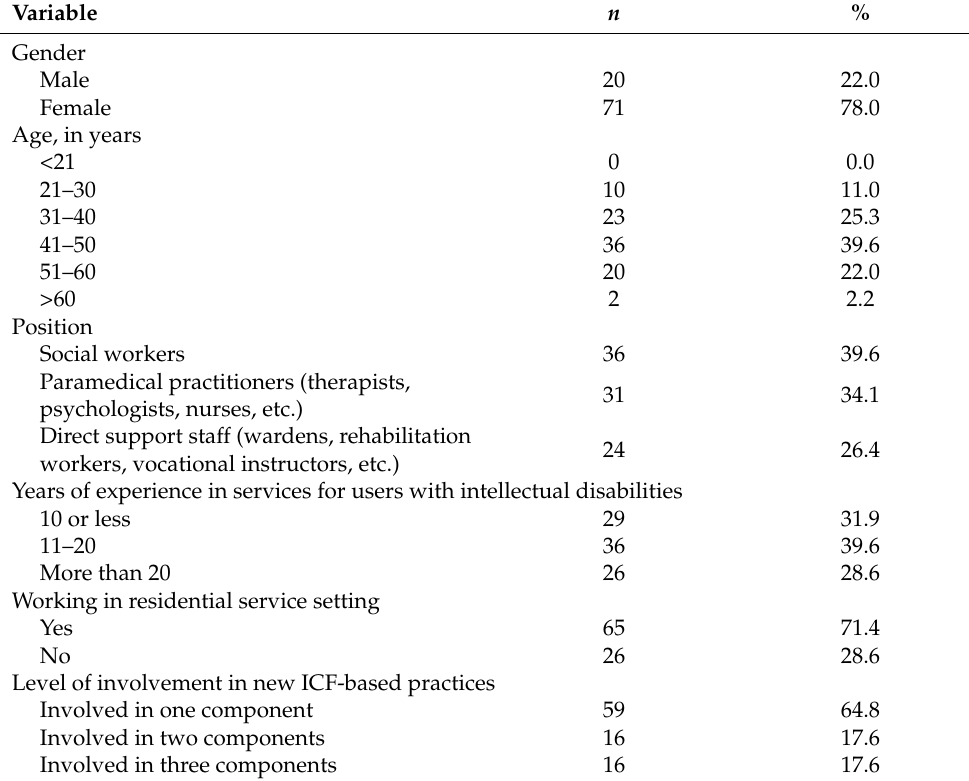
Table 1. Socio-demographic Characteristics of Participants ( N =